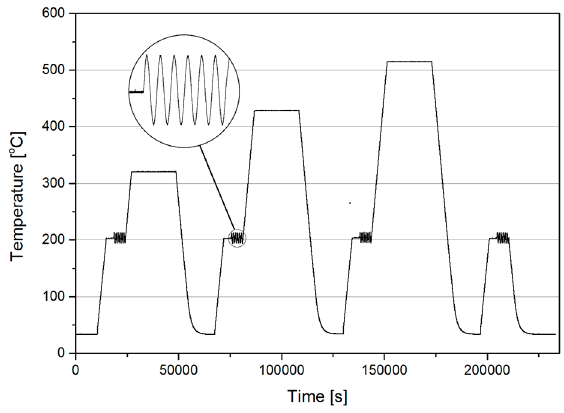
Figure 1. Thermogram to thermal stability diagnostics.